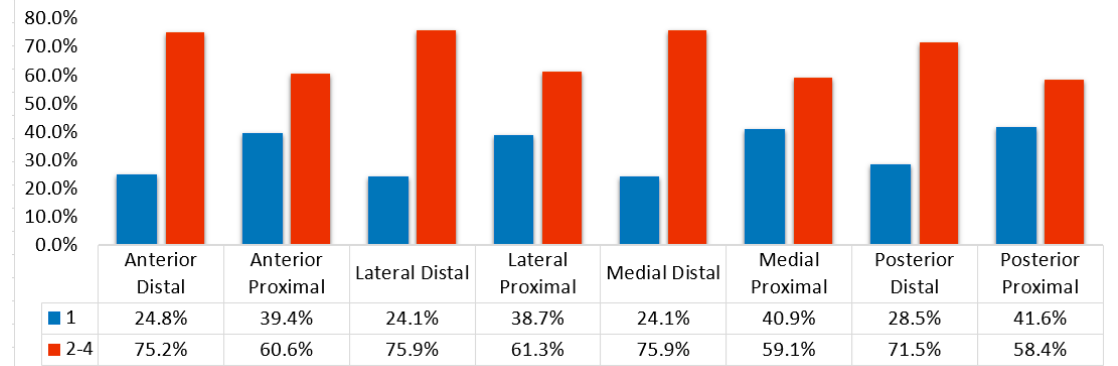
Figure 4. Distribution of corroded stem tapers against the intact group.